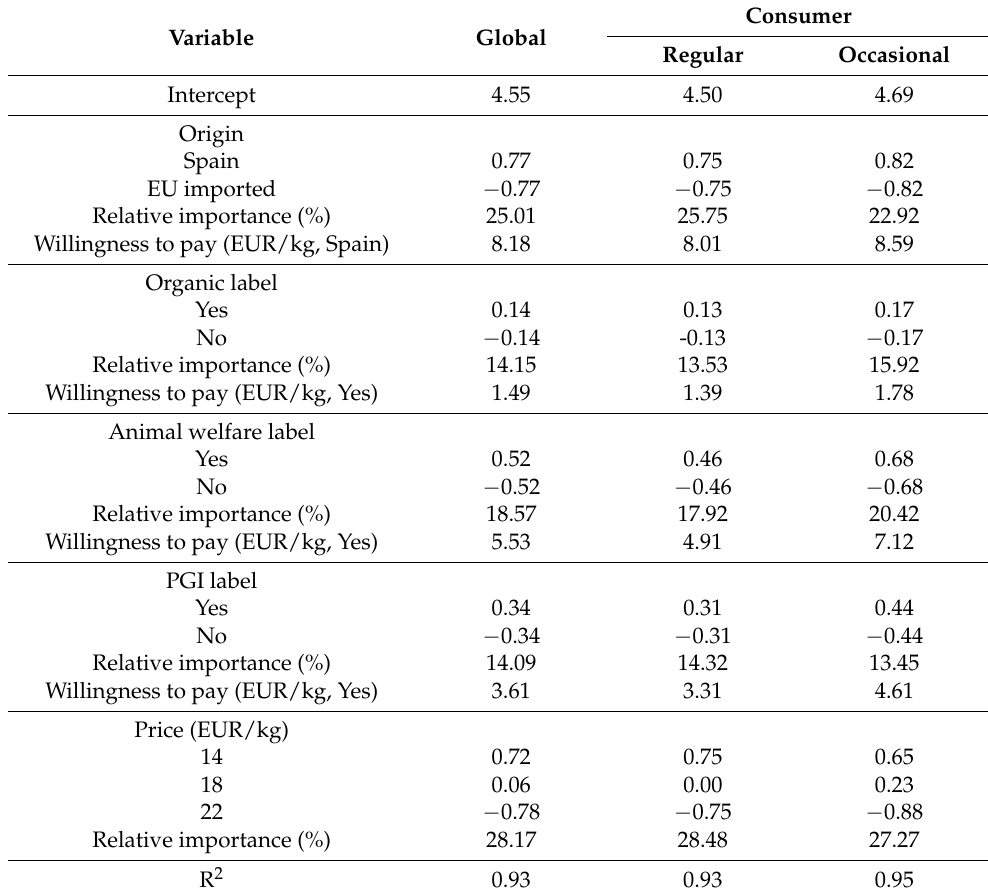
Table 3. Relative importance (%), utility values, and changes in willingness to pay (EUR/kg) for each attribute for all consumers, regular consumers, and occasional consumers of beef. Variable Global